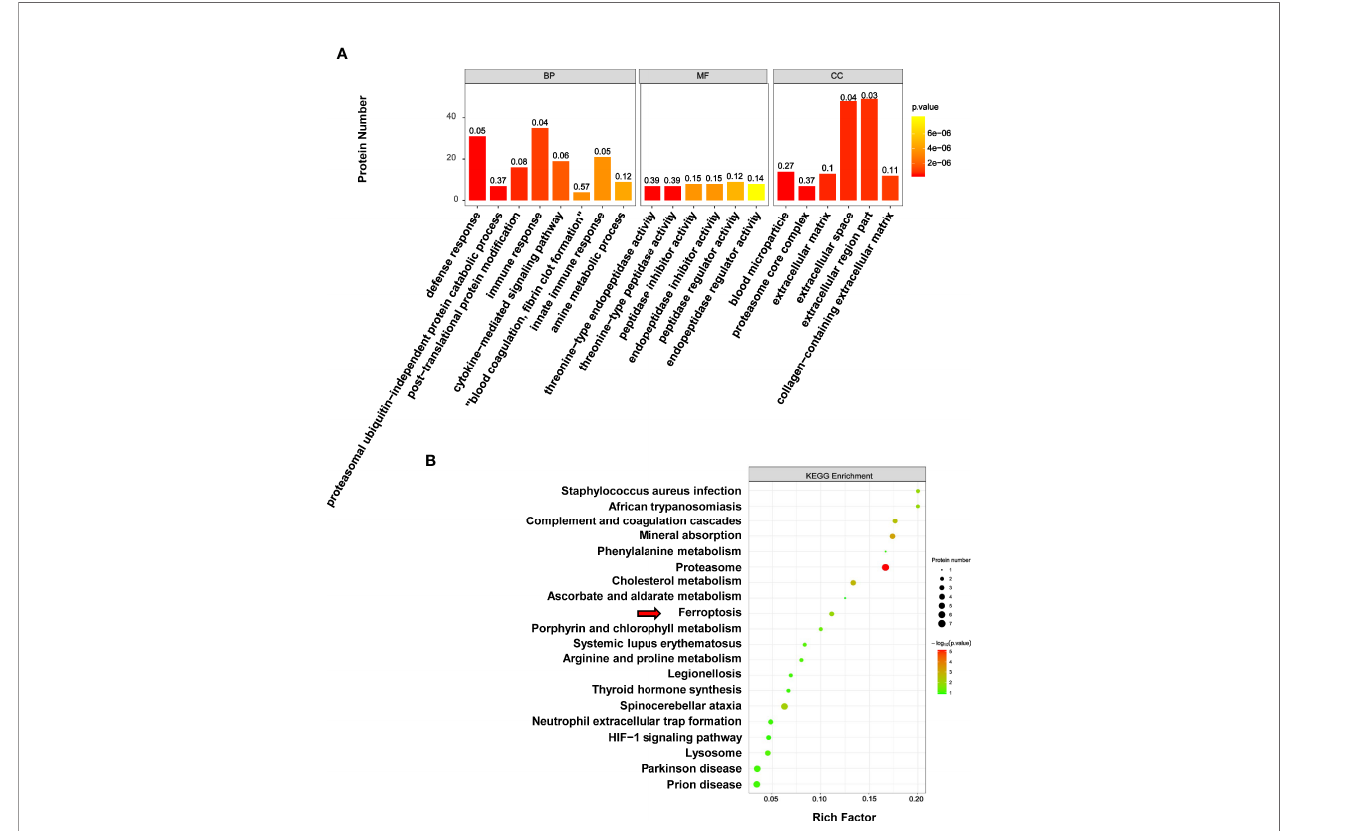
FIGURE 7 | GO and KEGG analysis of differentially expressed proteins associated with melanoma. (A) The results of GO reassignments showed that proteins were categorized biological process (BP), molecular function (MF), and cellular component (CC). (B) The top enriched 20 KEGG pathways were shown in scatter plot, and the ferroptosis pathway was indicated by red arrow.